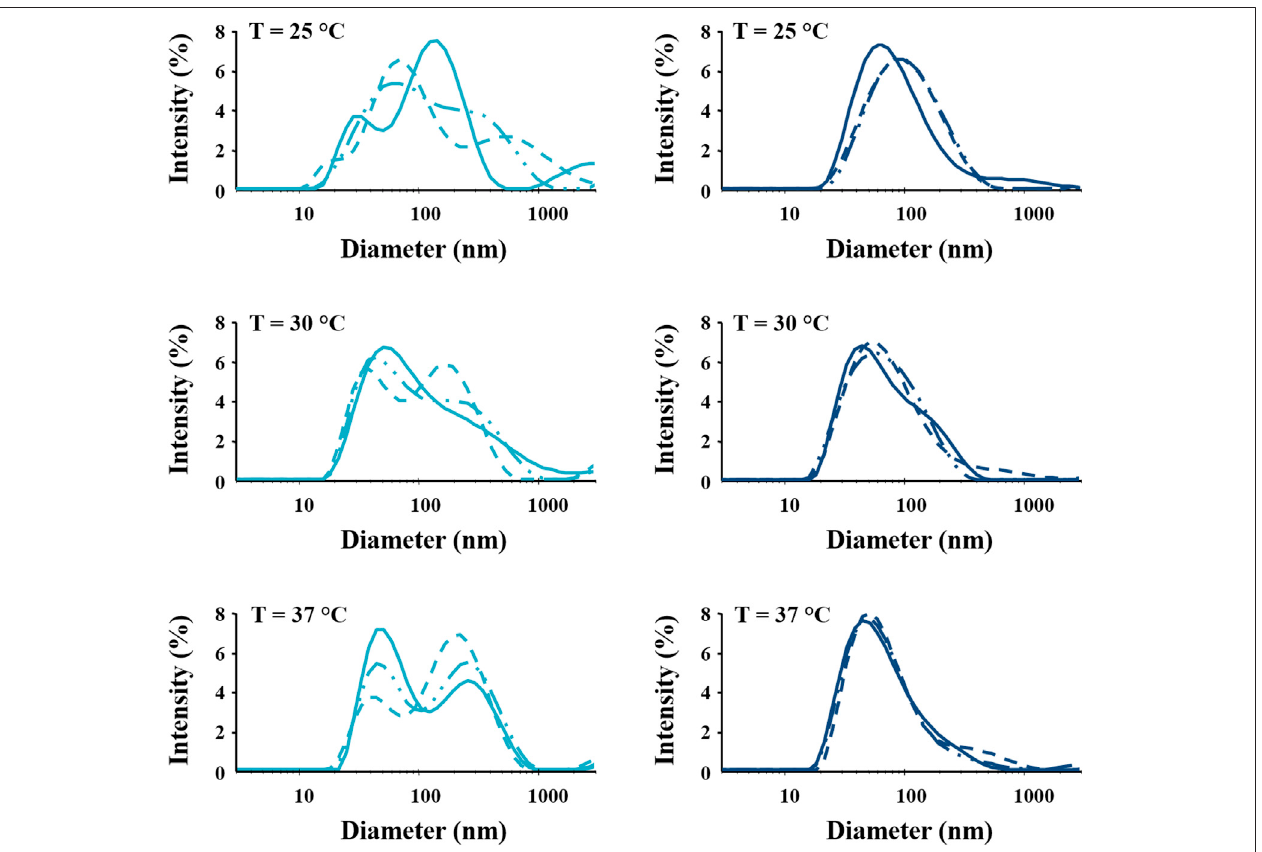
FIGURE3| Distributionpatterns(byintensity)ofmicellehydrodynamicdiametermeasuredinCHP407(lightblue)andCHP407_P(darkblue)solutionsat0.5%w/V concentration. Analyses were performed in triplicate (continuous, dashed and dashed-dot lines represent the three registered patterns) at 25 ° C, 30 ° C and 37 ° C.